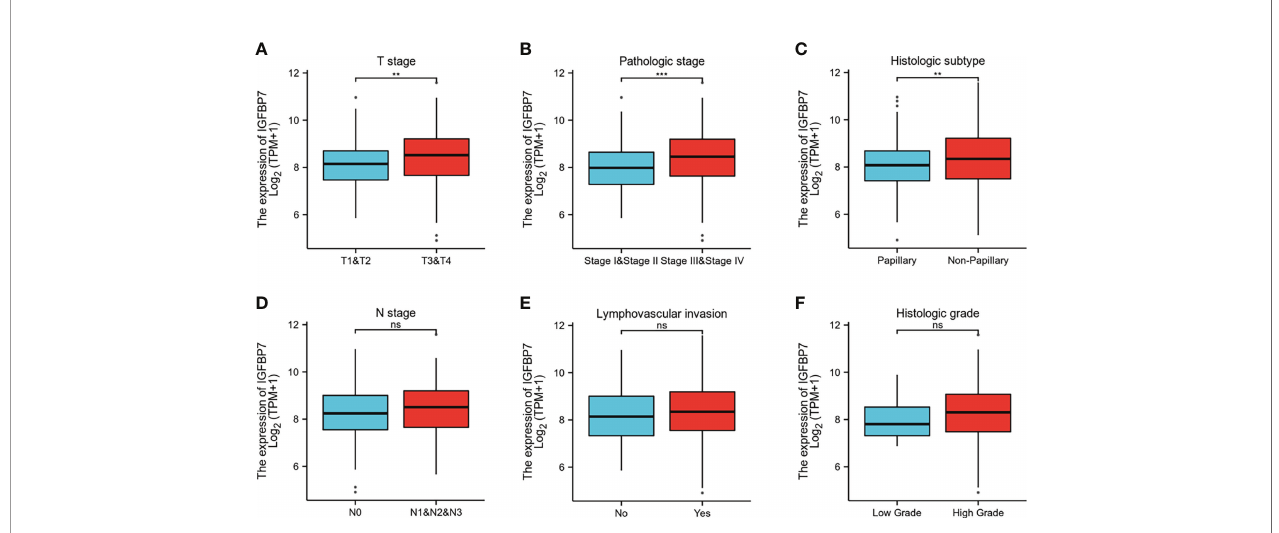
FIGURE 2 | IGFBP7 expression and clinicopathological features in BLCA. (A – C) High T stage, high pathologic stage and non-papillary subtype were associated with higher expressions of IGFBP7 in BLCA. (D – F) No statistically signi fi cant differences were found between the expression levels of IGFBP7 in BLCA and N stage, lymphovascular invasion and histologic grade. **p < 0.01; ***p < 0.001; ns, no signi fi